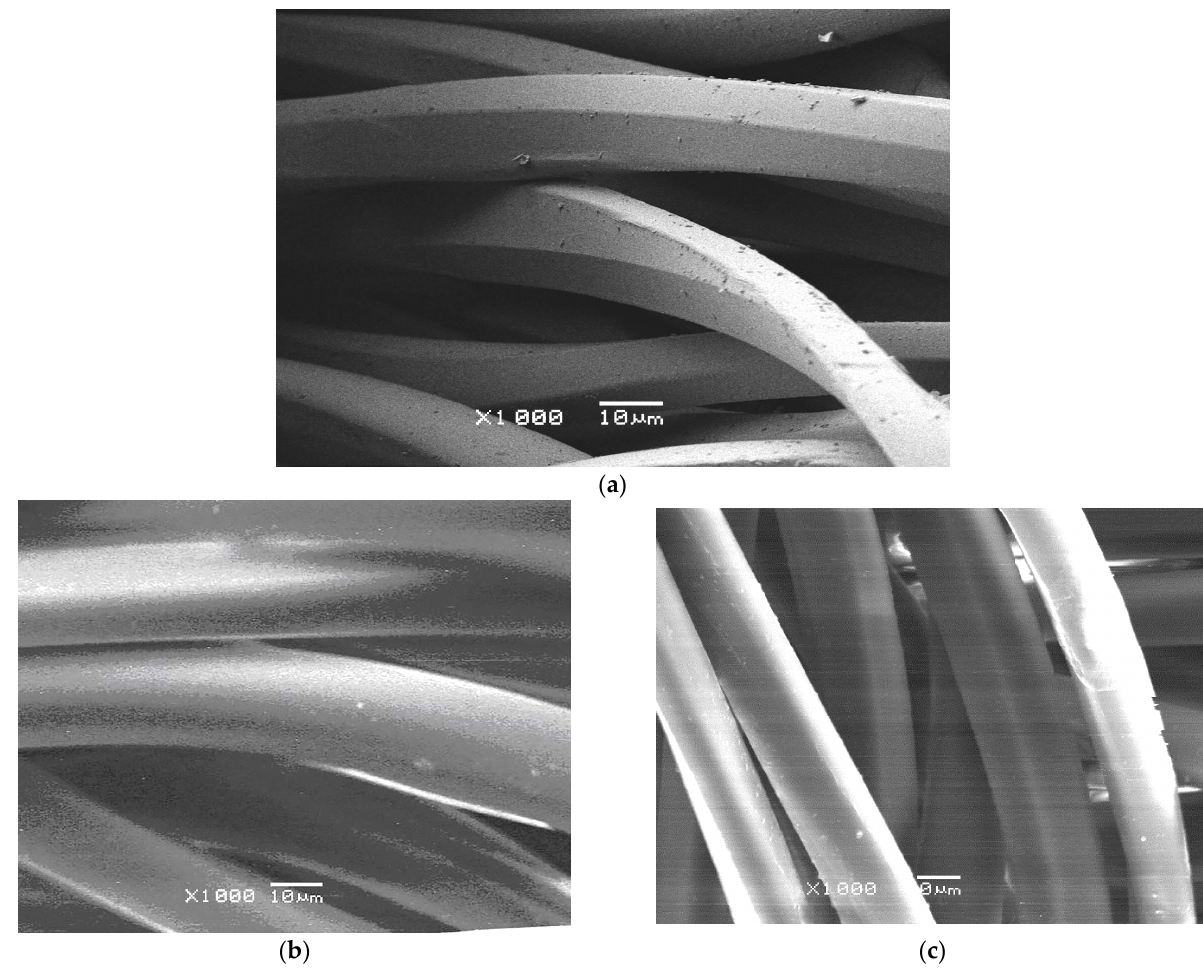
Figure 2. Image of the polyester fabric:( a ) is the initial polyester fabric; ( b ) is the UPTFE FORUM ® deposited from an SC-CO 2 medium; ( c ) is the TFE/BC telomers [32,43]. The study method is scanning electron microscopy.